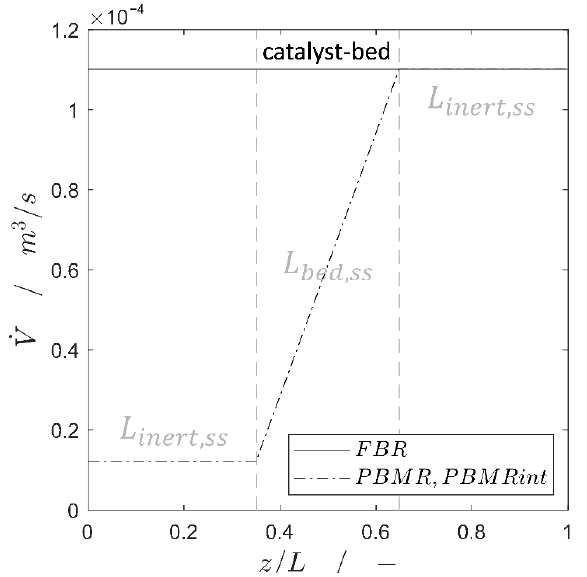
Figure 15. Total volumetric flow rates of the FBR and the membrane cases (PBMR, PBMRint) along the axial reactor coordinate.